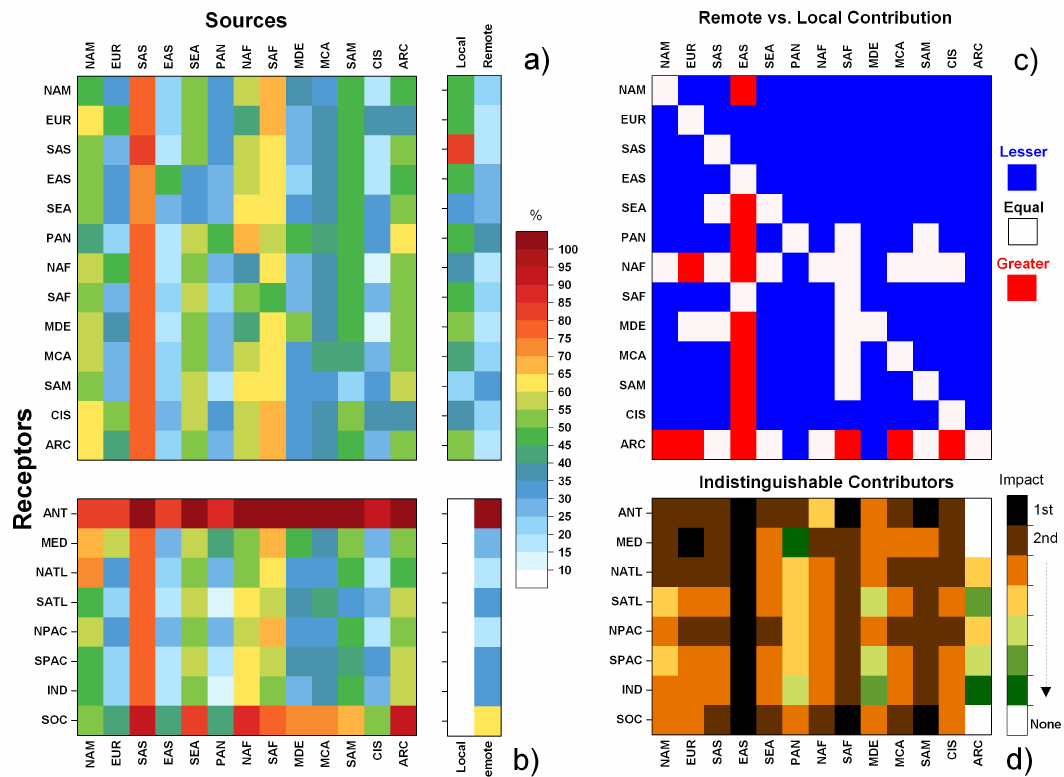
Figure 4. Source-Receptor matrices, in the form of heat-maps, showing, ( a , b ), the normalised confidence interval amplitudes for the mean (NCIAM) of the Hg total deposition; ( c ) the comparison between the local and each remote source region contributions (95% CI) and ( d ) the remote source contributors that are statistically indistinguishable (95% CI), in order of importance. In ( d ) source contributions that are statistically indistinguishable (at 95% CI) share the same colour. In ( a , b ) two columns are detached depicting the uncertainty due to the local contribution (i.e., the main diagonal of the SR Matrix) and the overall remote contribution, respectively. Both mean and CI (at 95%) were calculated using the bootstrap method [23] starting from the ensemble of simulations reported in Table 1. Panels ( a ) and ( b ) show visually the information in Table 2, highlighting the greater uncertainty in Hg from SAS (South Asia), SEA (South East Asia), NAM (North America), Southern (SAF) and Northern Africa (NAF), and also the Arctic